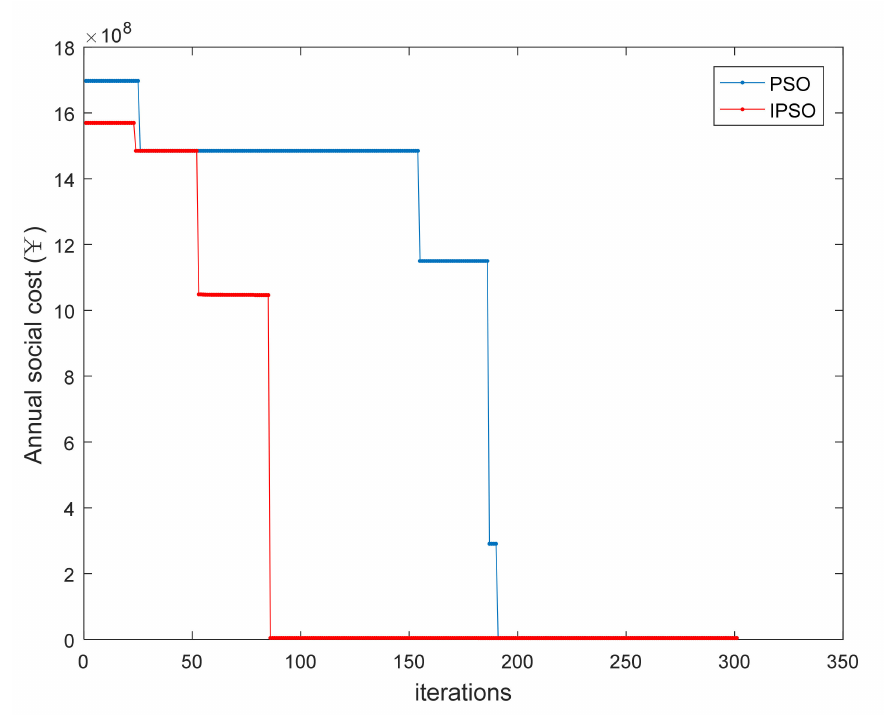
Figure 6. The iterative process.